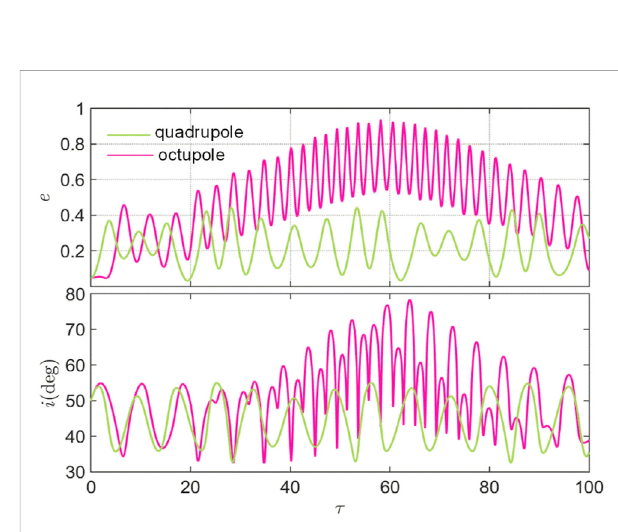
FIGURE 12 Eccentricity and inclination evolution over 100 scaled time for ε (cid:2) 0 . 1 by using the quadrupole-level and octupole-level models. Oct The other conditions are set the same as Figure (cid:2) B